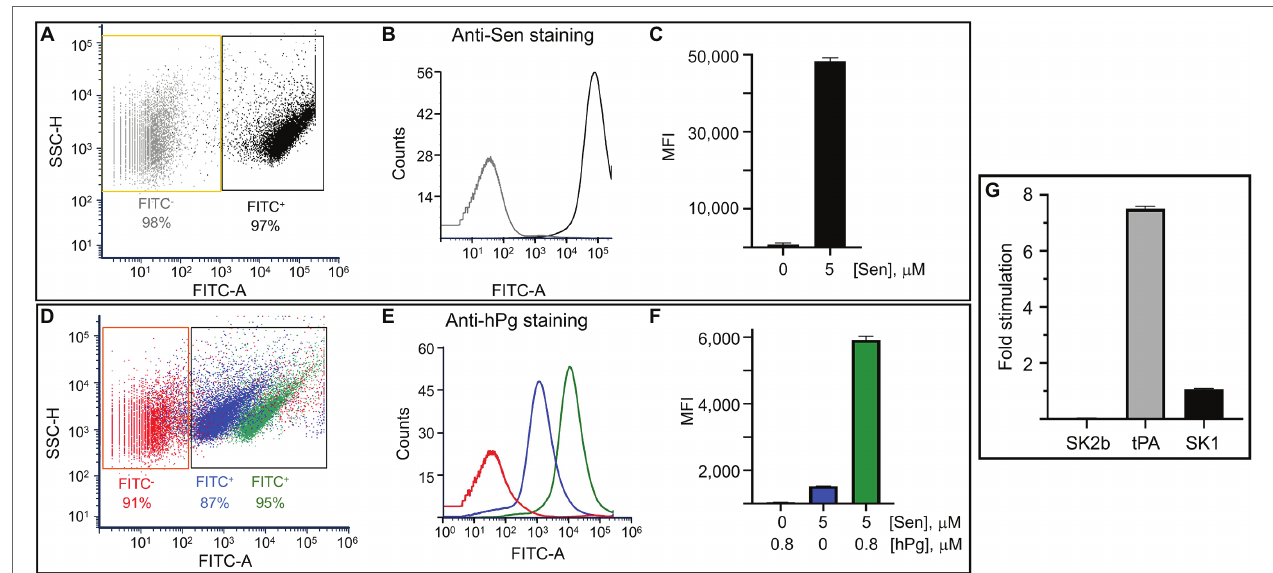
FIGURE 5 | The interaction of Sen with DOPG vesicles as measured by flow cytometric analysis (FCA). (A) Dot plot overlay of DOPG vesicles incubated with Sen (0-gray or 5 μ M-black) followed by rabbit anti-Sen and FITC-chicken-anti-rabbit IgG. The plot shows the side scatter of DOPG vs. FITC-derived fluorescence and the FITC-based gates that define Sen-bound and non-bound DOPG vesicles. (B) Histogram overlay of DOPG from A vs. FITC intensity. (C) Bar representation of median fluorescence intensity (MFI) obtained from B. (D) Dot plot overlay of DOPG vesicles incubated with Sen (0- red or 5 mM—blue and green) followed by hPg (0—blue or 0.8 μ M—red and green), then mouse anti-hPg and FITC-donkey-anti-mouse IgG. The plot shows the side scatter of DOPG against FITC-derived fluorescence and the FITC-based gates that define IgG-bound and non-bound DOPG vesicles. (E) Histogram overlay of DOPG from D vs FITC intensity. (F) Bar representation of median fluorescence intensity obtained from E. (G) Stimulatory effect of PL-bound Sen on the activity of hPg activators. PL vesicles (0.1 mM) pre- blocked in 2.5% BSA were subjected to 1 h incubation in 0 or 5 μ M Sen. The PL was washed, resuspended in PBS, and added in replicates to wells of a non- protein binding 96-well microtiter plate. hPg (200 nM, final; concentration) was next added, after which a mixture of chromogenic substrate, S2251 (H-D-Val-Leu- Lys-pNA; 0.25 mM) admixed with SK2b, tPA, or SK1 (5 μ M). The reaction was continuously monitored for 120 min at A 405nm . The fold increase in reaction velocity was calculated by dividing the initial velocities of assays performed in PL-Sen (5 μ M) by those performed in PL-Sen